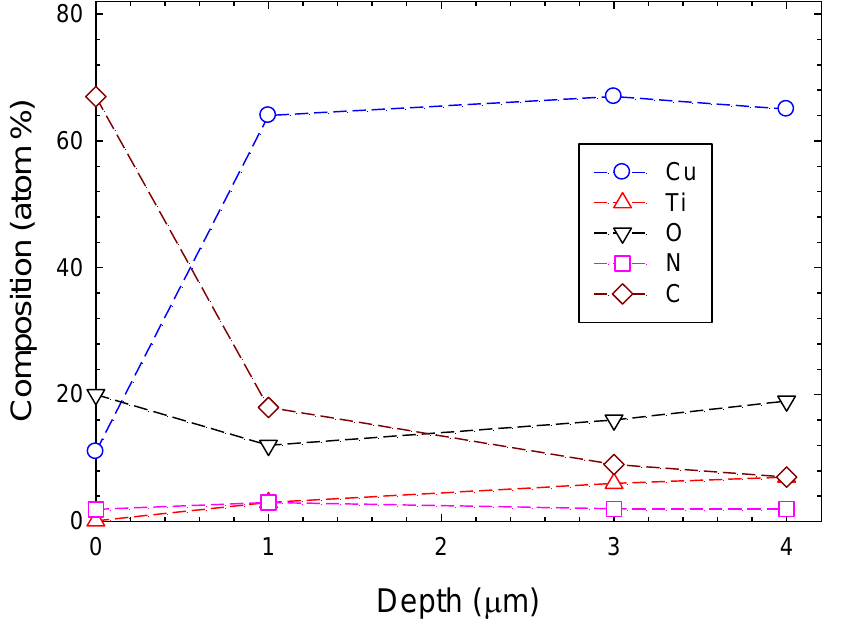
Figure 3. Relative composition (in atom %) as a function of film depth of the deposited Ti-CuN film. Dashed lines are to guide the eye only.